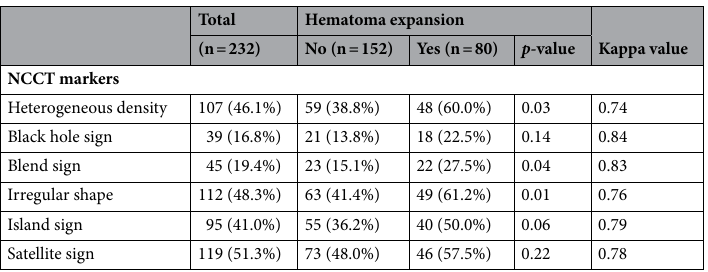
Table 3. NCCT predictive markers of HE. NCCT, non-contrast computed tomography; HE, hematoma